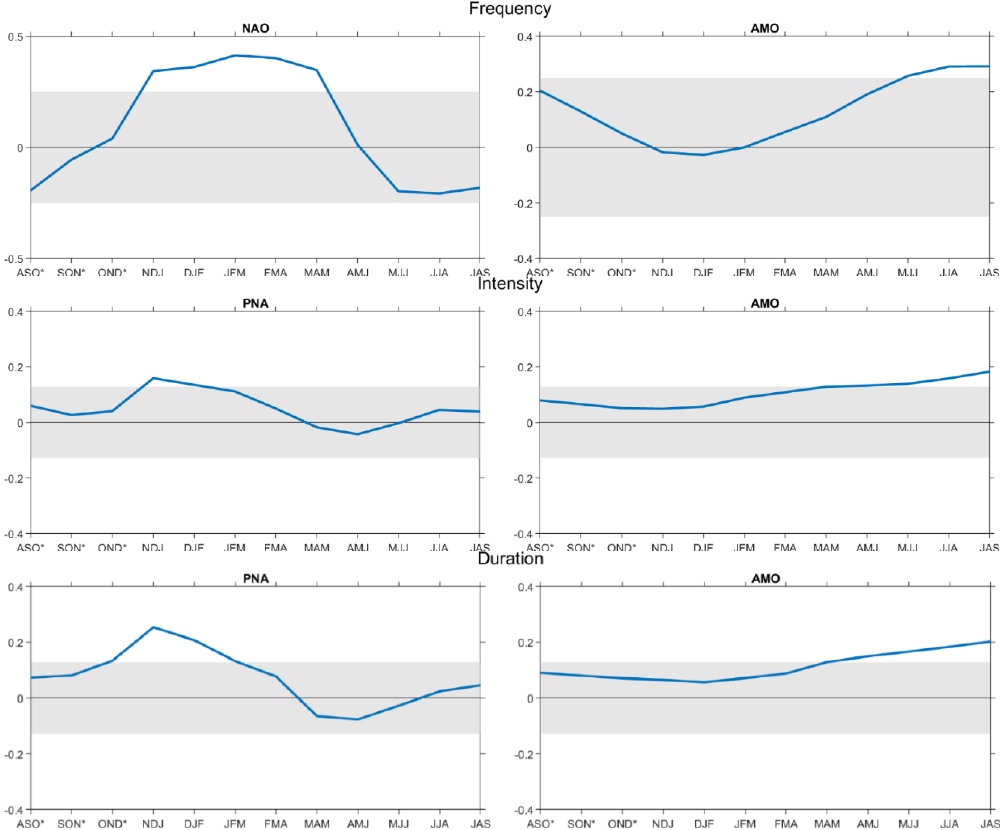
Figure 5. Seasonal temporal evolution of the correlation coefficient between the heat spell variables in Orange and the selected climate indices. * denotes a season before the current year of the observed heat spells. The shaded area represents the limits where correlations are significant at a 5% level.